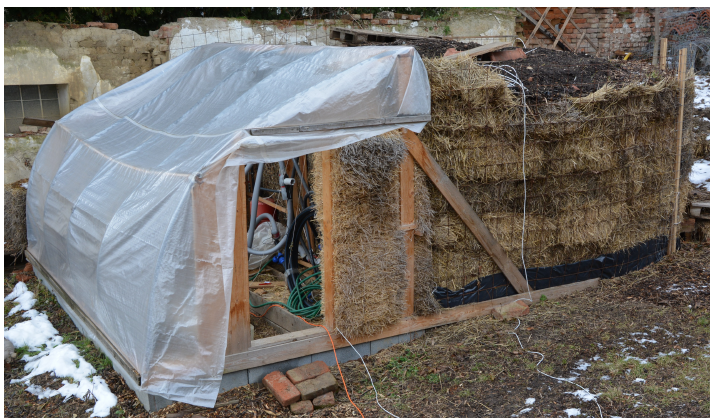
Figure 13. Composting bioreactor before final connection of heat recovery and temperature measurement circuits.